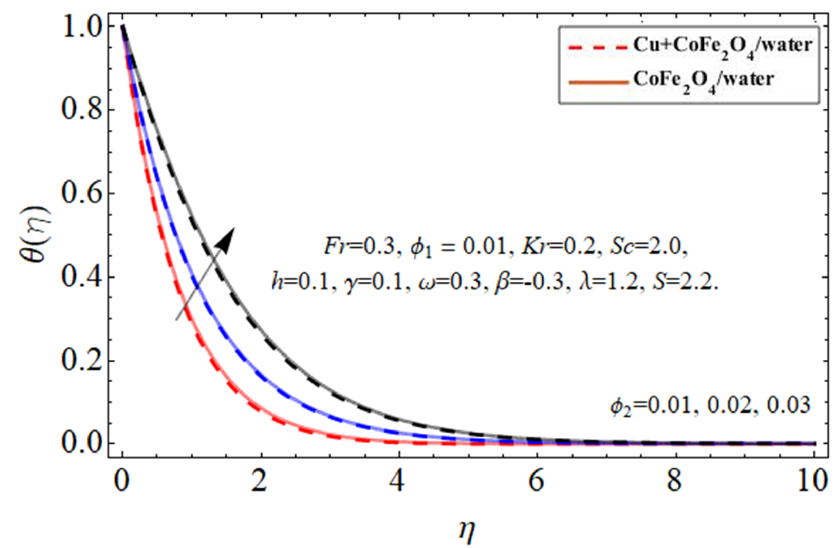
( ) θ η ( η ) field against cobalt ferrite φ ( ) θ η field against cobalt ferrite 2 field against cobalt ferrite 2